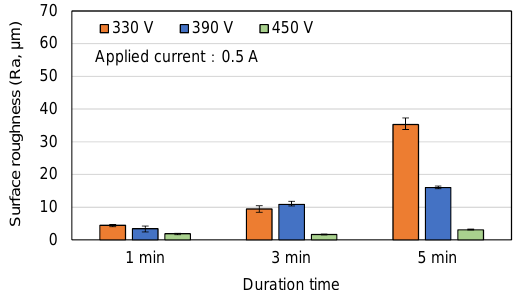
Figure 4. Surface roughness of MAO coatings prepared with different applied voltages and duration times and constant applied current of 0.4 A.